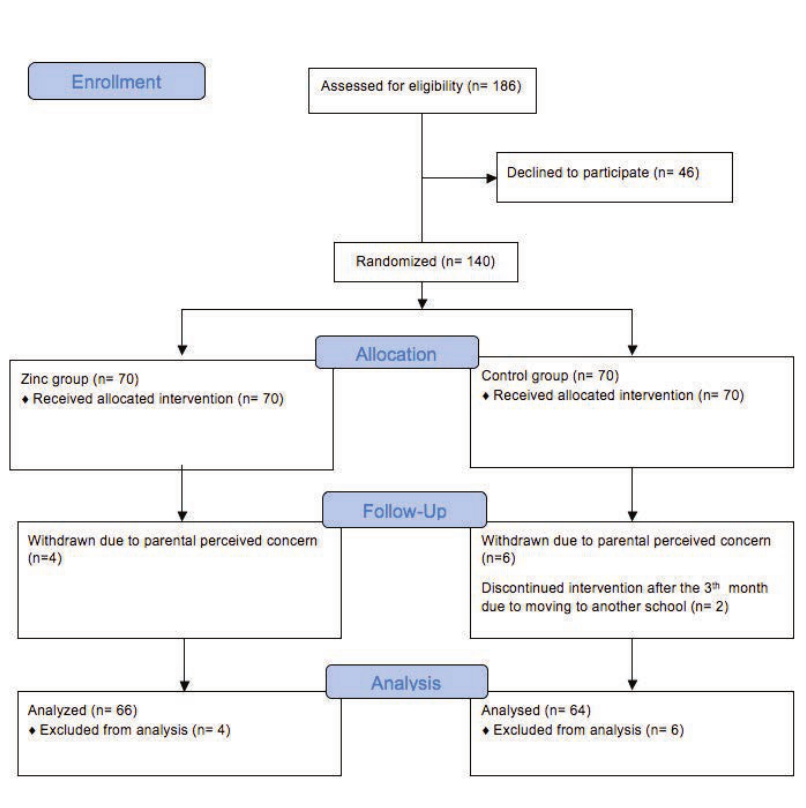
Figure 1. Study flow chart and